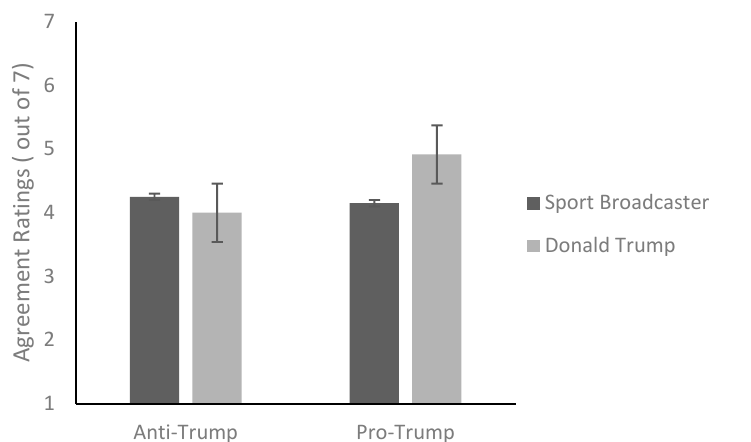
Figure 3. Agreement with the team name change on financial grounds by participant on the degree of Trump support and statement source.